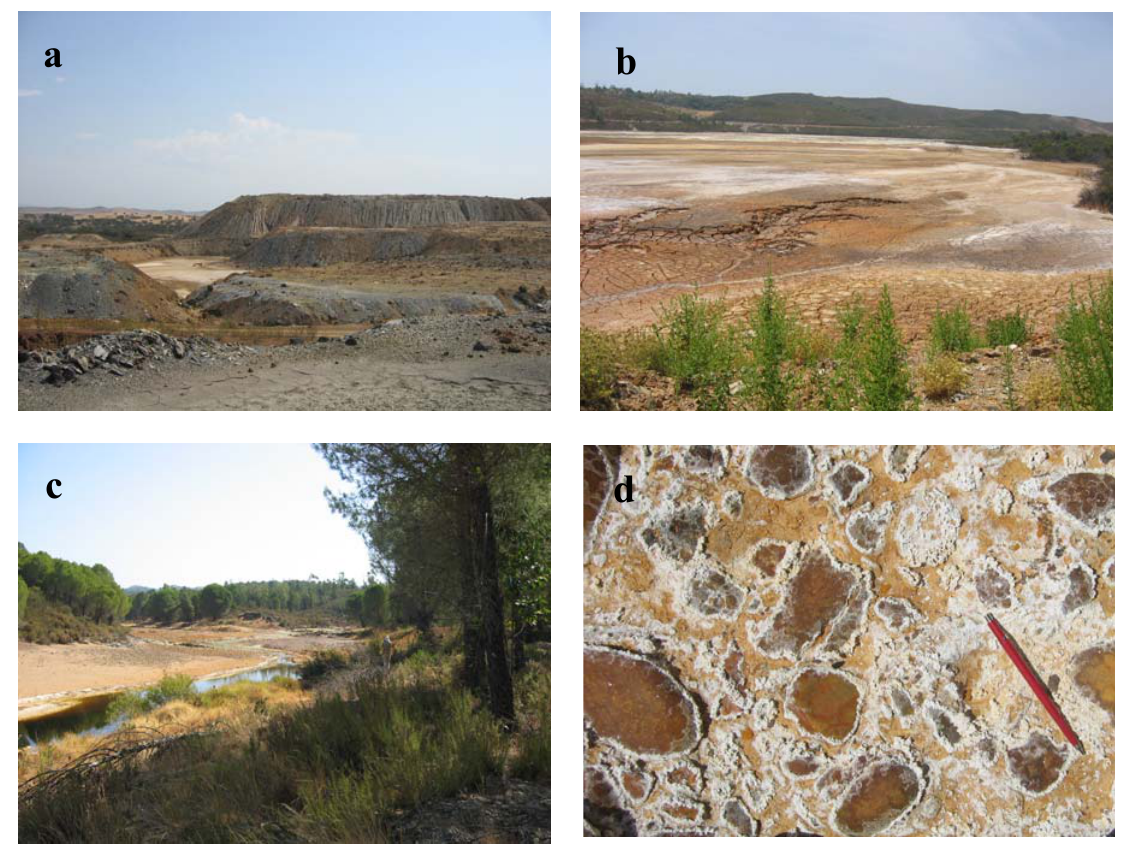
(b) . Drainage with oxidized crusts developed on a surface of hydrated sulfate on the mill tailings dam of the Sotiel-Almagrera mine site. (c) View of sandbar development on the Odiel River, with coarse boulders on the sands, rimmed by white crusts of hydrated sulfate at the edge of the water. (d) Development of white hydrated iron sulfate crusts over oxidized boulders from sediments taken from the Odiel